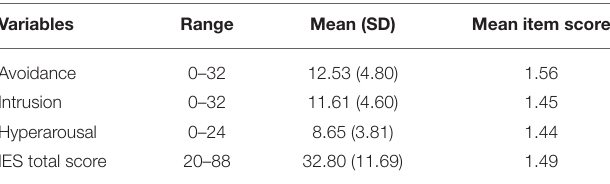
TABLE 1 | PTSS, scores, and dimensions in the adolescents who scored ≥ 20 ( N = 62,668).